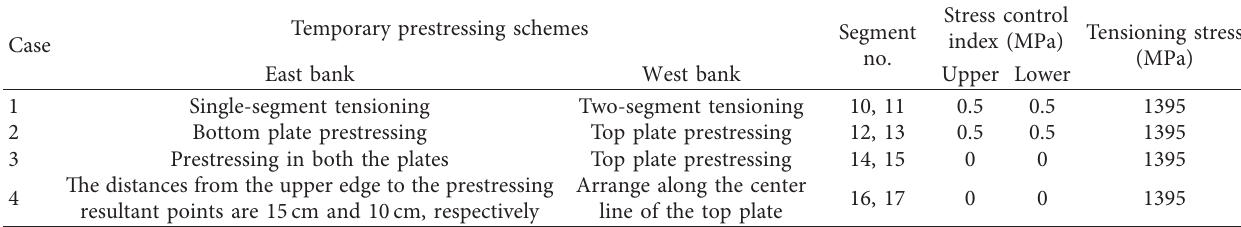
Table 3: Comparison objects of temporary prestressing between the east and west bank cases.